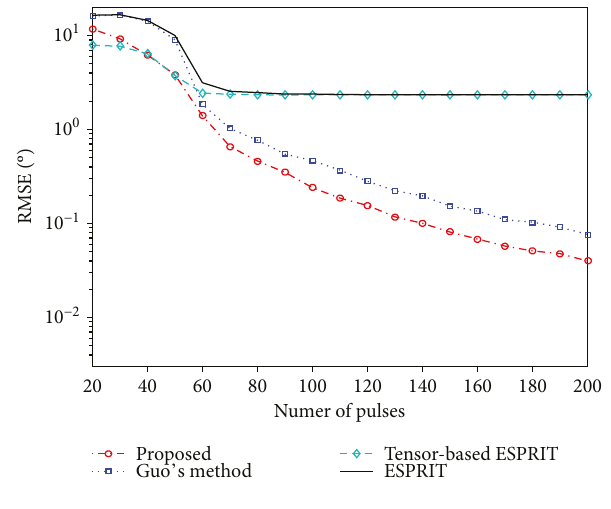
Figure 4: RMSE versus